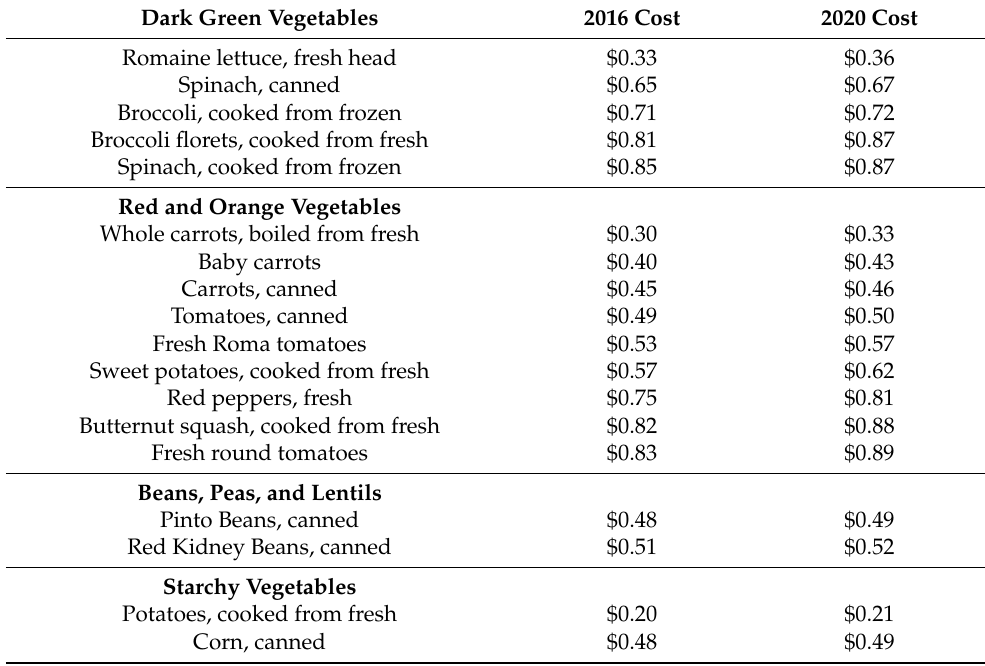
Table 2. Costs of selected vegetables per cup-equivalent, 2016 and 2020. Dark Green